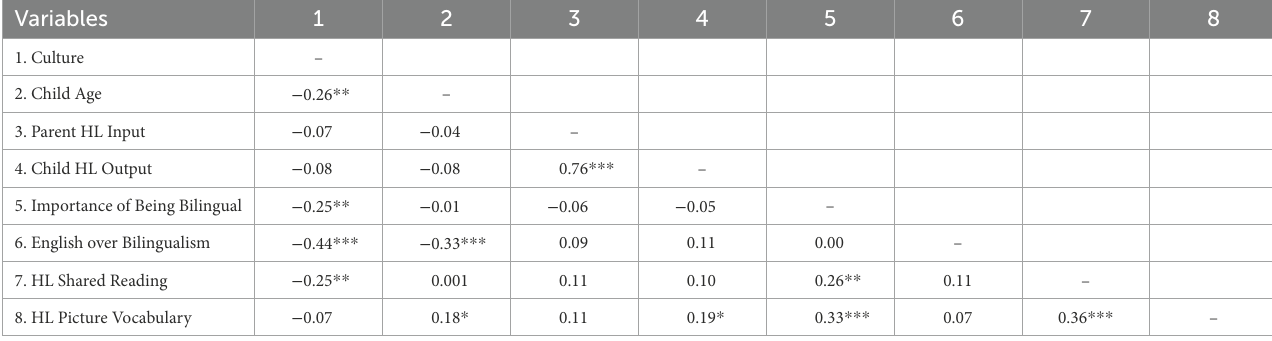
TABLE 3 Correlation among the study